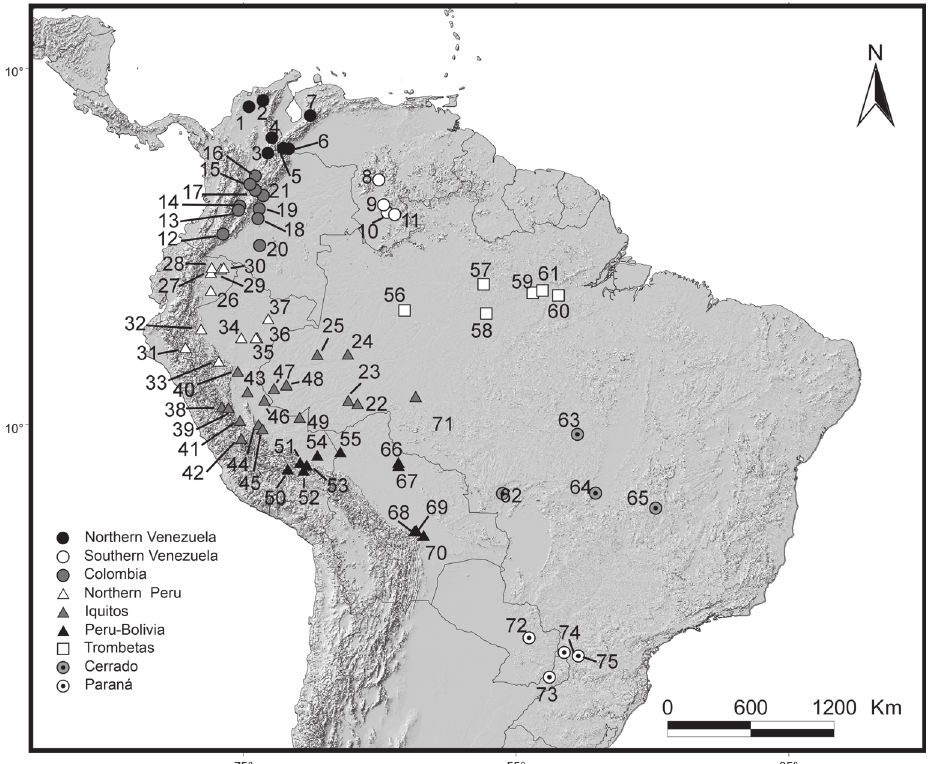
Figure 3. Distribution of the localities of Caluromys lanatus with specimens included in this study. Localities were grouped in populations for subsequent analyses, and are labelled accordingly. Numbers indicate localities as listed in Appendix